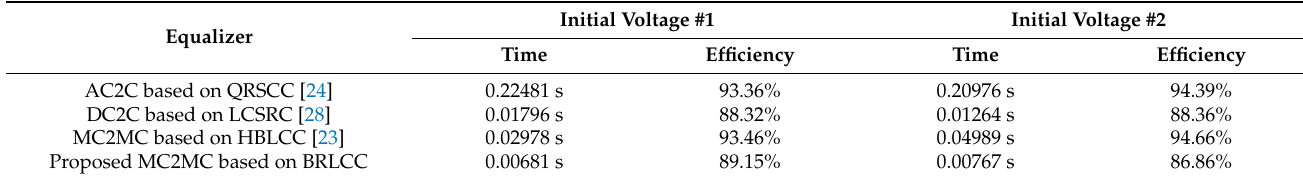
Table 1. Simulation comparison of different equalizers with initial voltages #1 and #2.